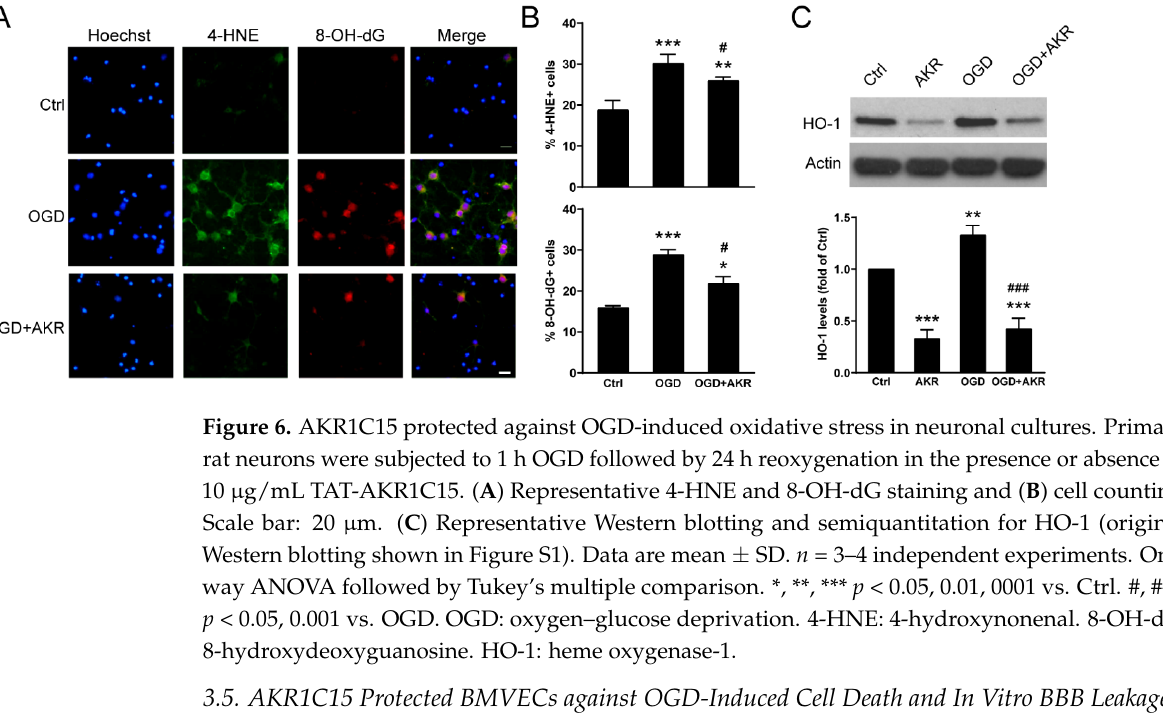
Figure 6. AKR1C15 protected against OGD-induced oxidative stress in neuronal cultures. Primary rat neurons were subjected to 1 h OGD followed by 24 h reoxygenation in the presence or absence of 10 µg/mL TAT-AKR1C15. ( A ) Representative 4-HNE and 8-OH-dG staining and ( B ) cell counting. Scale bar: 20 µm. ( C ) Representative Western blotting and semiquantitation for HO-1 (original West- ern blotting shown in Figure S1). Data are mean ± SD. n = 3–4 independent experiments. One-way